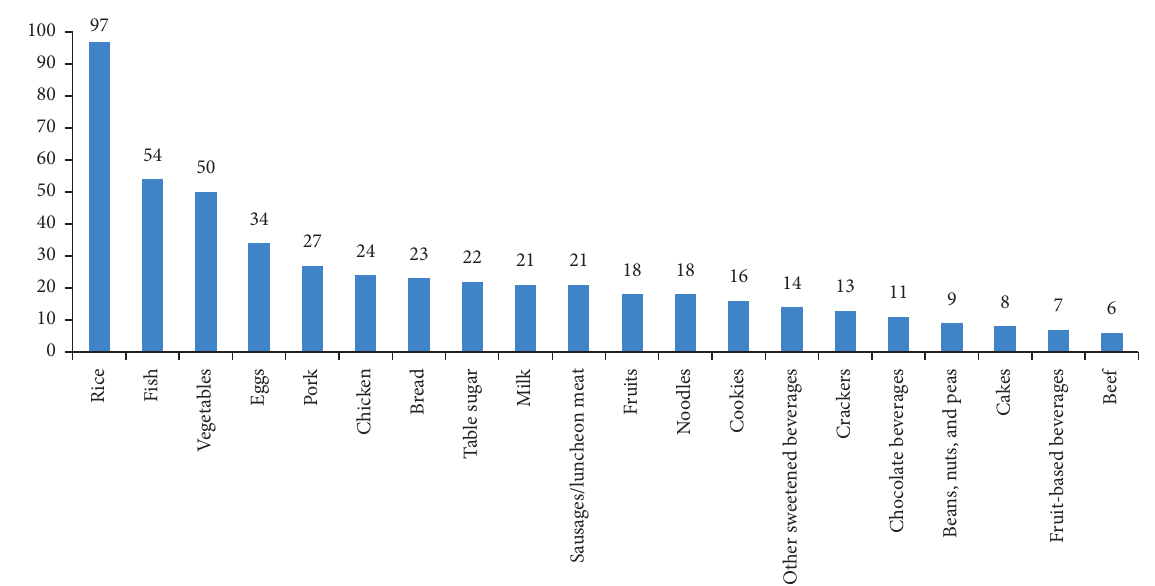
Figure 1: Most commonly consumed foods of children aged 6–12 years. Table 6: Food sources of total vitamin D by island groups ( n �